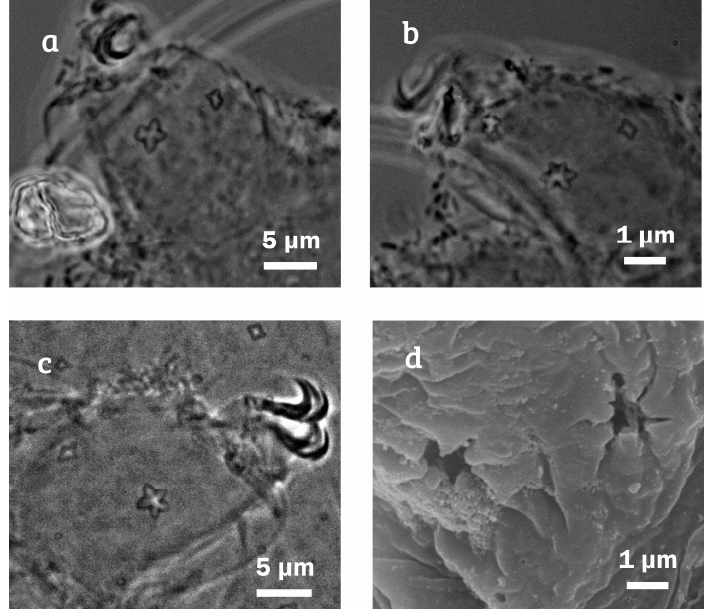
Figure 3. Minibiotus citlalium sp. nov. pair of star-shaped pores, one of them conspicuously larger. ( a ) Leg II, paratype 1 (PCM); ( b ) leg III, paratype 1 (PCM); ( c ) leg II, paratype 11 (PCM); and ( d ) leg III with both star-shaped pores on external surface (SEM).